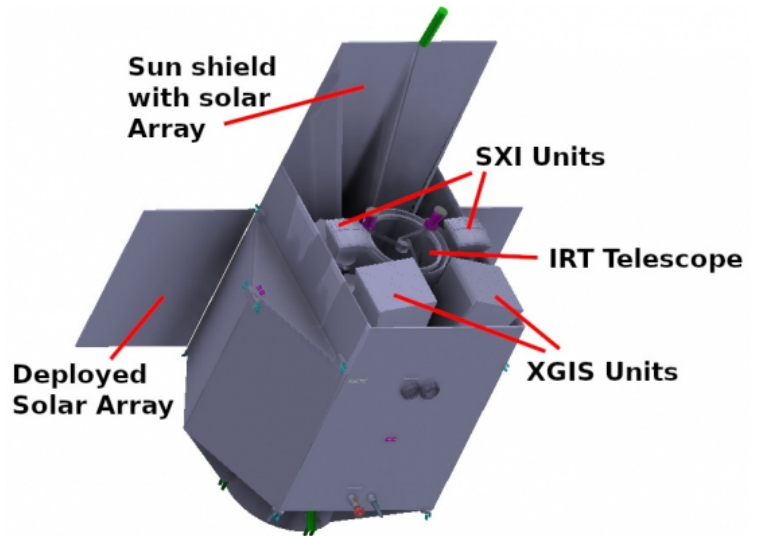
Figure 1. Possible spacecraft design and payload accomodation of THESEUS (Credit: ESA and THESEUS